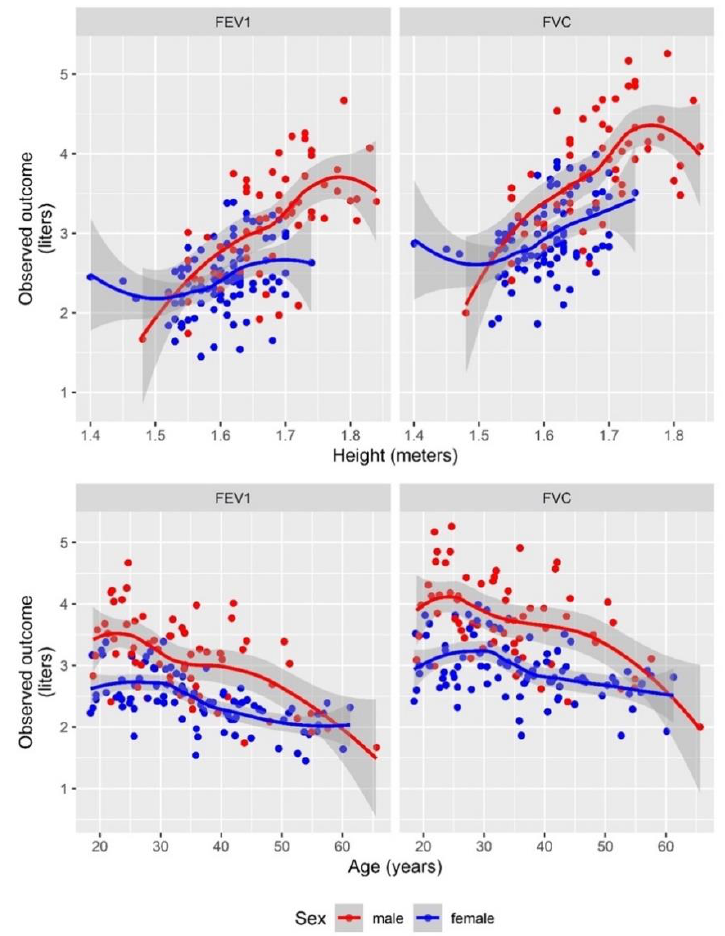
Figure 1. Association of FVC and FEV1 values with height and age and according to sex.